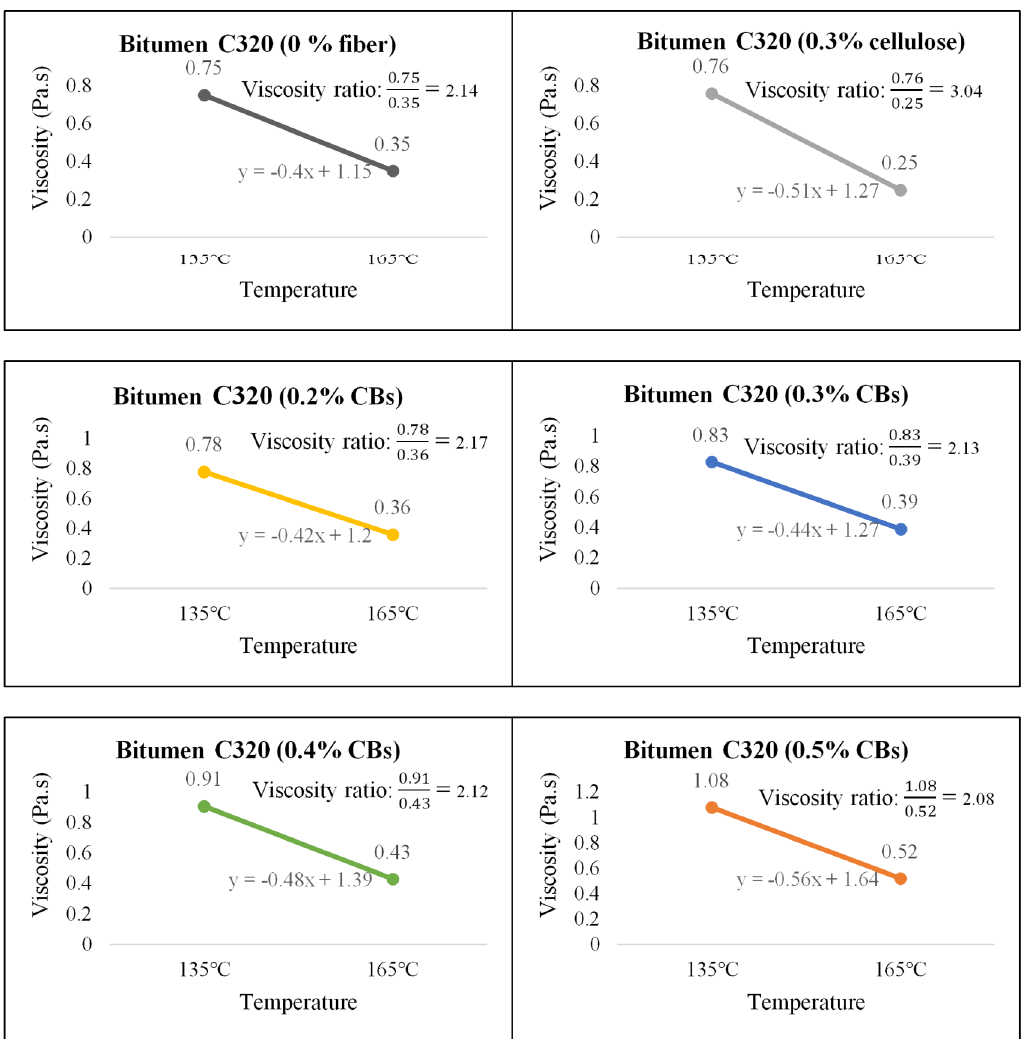
Figure 14. Viscosity ratio and slope of Bitumen C320 with cellulose fiber and different % of CBs content.